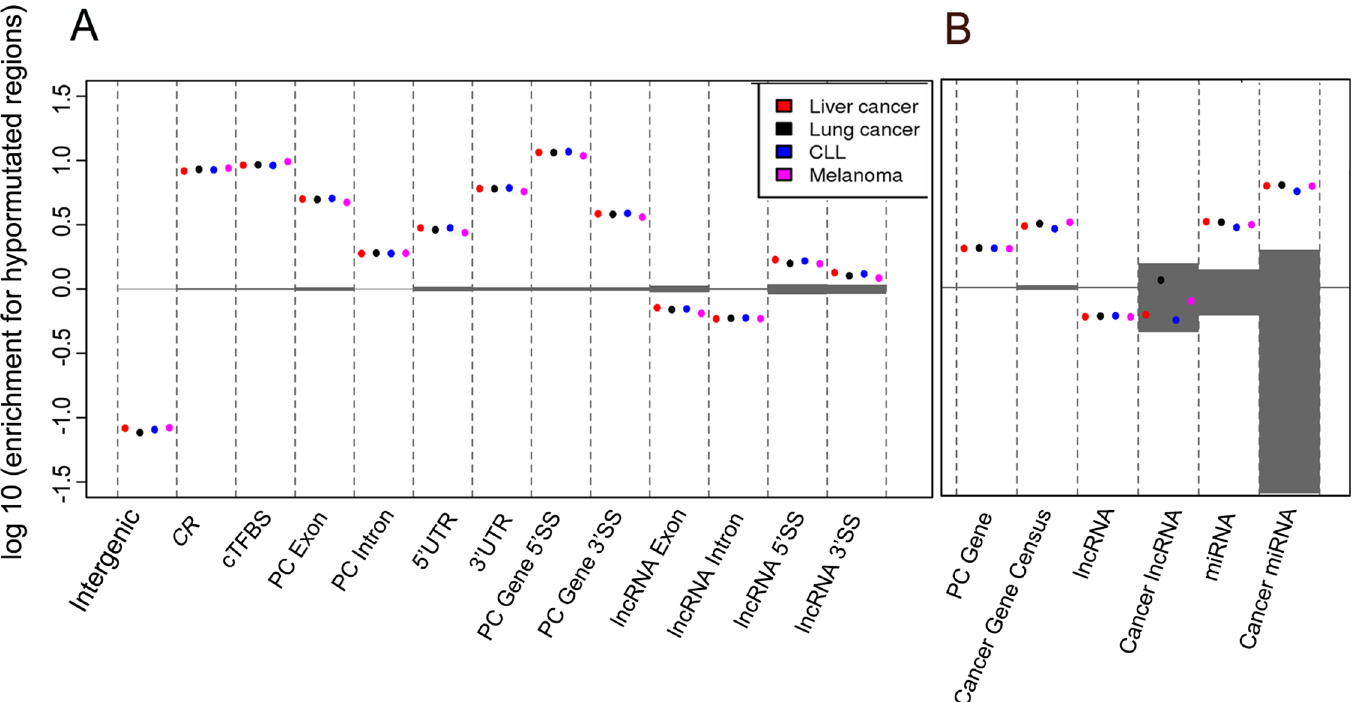
Fig 4. Enrichment for hypomutated positions within different genome features (A) and gene classes (B). Positive values indicate enrichment, negative values indicate depletion. Hypomutated (high SNP, low SOM) positions were mapped onto genome features (A) or genes from three different classes (Protein-coding, lncRNA, miRNA) (B). For each feature or gene class, enrichment for hypomutated positions was computed as explained in Methods. As hypomutated positions are cancer-specific, different results are obtained for each cancer class (colored dots). Shaded grey areas show enrichment ranges obtained from 1000 random permutations (see